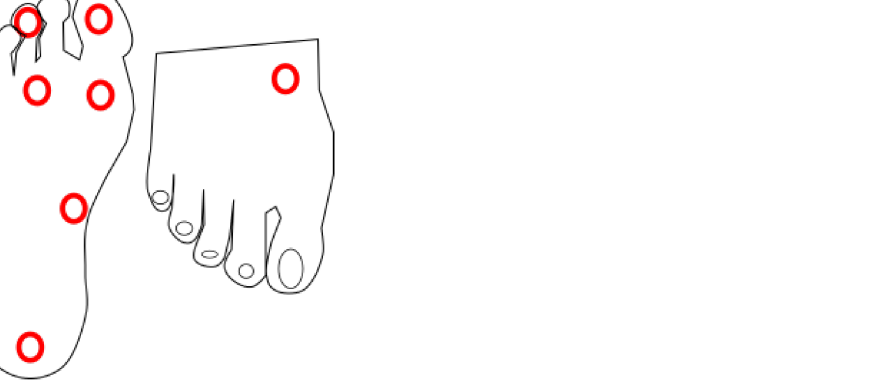
Figure 9. Schematic representation of the 10-point pattern used for the monofilament neuropathy